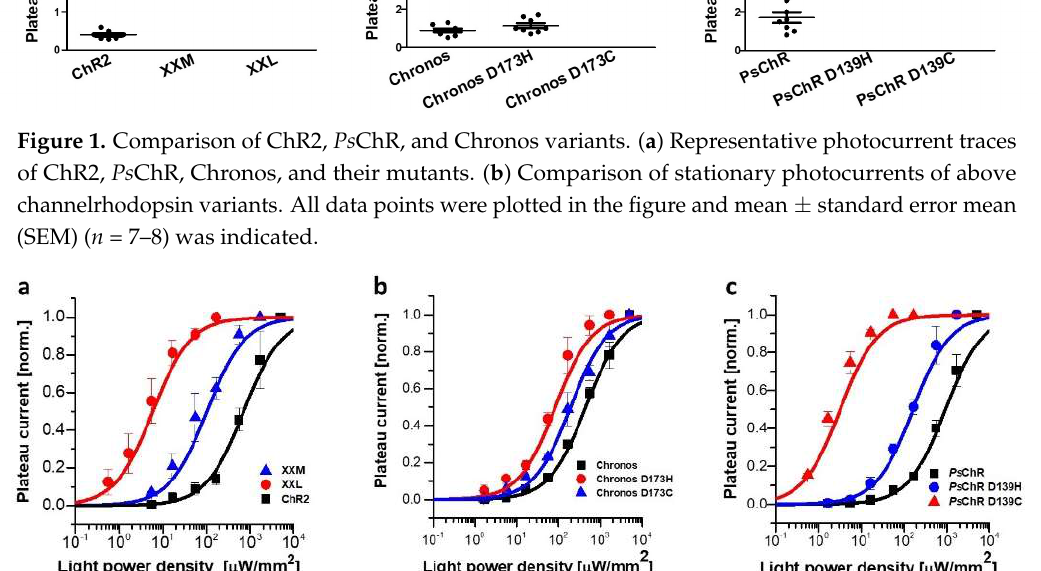
Figure 2. Comparing the light sensitivities of ChR2, Ps ChR, and Chronos variants. ( a ) 5 s, 30 s, and 100 s continuous 473 nm blue light illumination were applied to ChR2, XXM and XXL, respectively. Photocurrent at maximum light power density of each oocyte was normalized as 1. ( b ) 5 s continuous 532 nm blue light illumination were applied to Chronos, Chronos D173H, and Chronos D173C. Photocurrent at maximum light power density of each oocyte was normalized as 1. ( c ) 5 s, 30 s, and 100 s continuous 445 nm blue light illumination were applied to Ps ChR, Ps ChR D139H, and Ps ChR D139C. Photocurrent at maximum light power density of each oocyte was normalized as 1. Photocurrents of XXM, XXL, Ps ChR D139H, and Ps ChR D139C were measured at − 60 mV because of the larger current and slower kinetics; other constructs were measured at − 100 mV. Data points were presented as mean ± SD, n = 3–4.